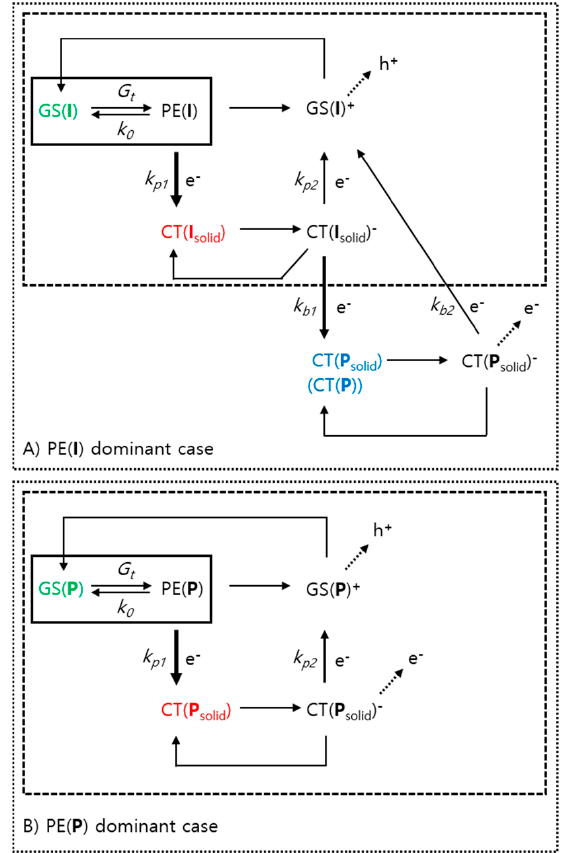
Figure 7. Decay paths of ( A ) PE( I ) and ( B ) PE( P ) as reaction schema. The reactions in boxes with solid lines correspond to solution samples, while the boxes with dashed lines correspond to additional reaction paths after film forming. Boxes with dotted lines correspond to additional dissipation paths in cooperation with P in blend film samples.